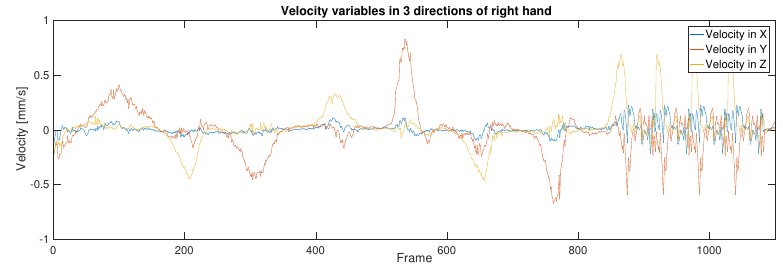
Figure 12. Motion velocity of the right hand of the human operator in 3